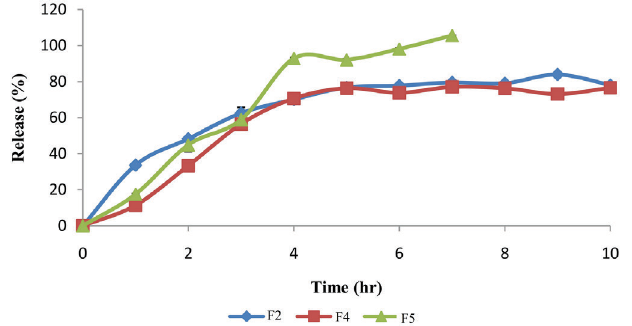
FIGURE 7 - Effect of the concentration of tripolyphosphate and drying method on the FLB release from chitosan microspheres in PBS: F1 (1% TPP); F2 (2% TPP); F1 and F2 were dried in the oven and F3 (2% TPP) was dried under vacuum.